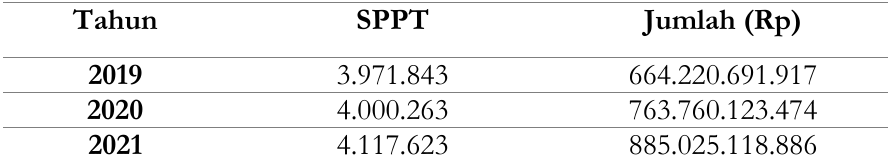
Table III Final Balance of SPPT PBB-P2 Accounts Receivable in Bekasi City